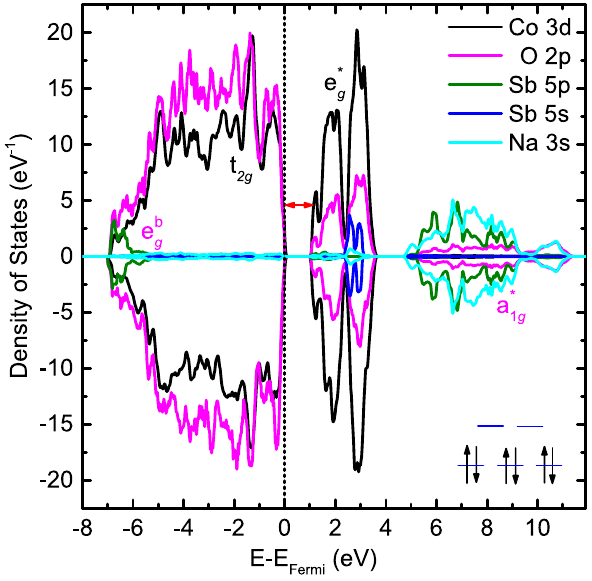
Fig. 2 The partial density of states (PDOS) of Sb Na 0.875 CoO 2 . The black and pink lines represent O 2p and Co’s 3d PDOS, respectively while the blue and green lines represent Sb 5 s and 5p states, respectively. The cyan lines represent Na 3 s states. The electronic configuration of Co 3+ is schematically shown in the inset at the bottom right